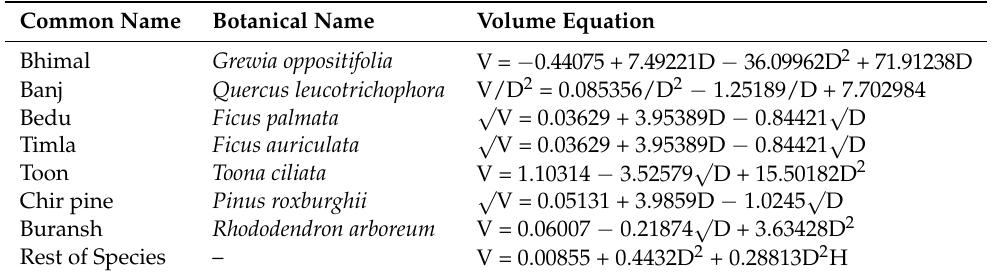
Table 2. Volume equation of different tree species.